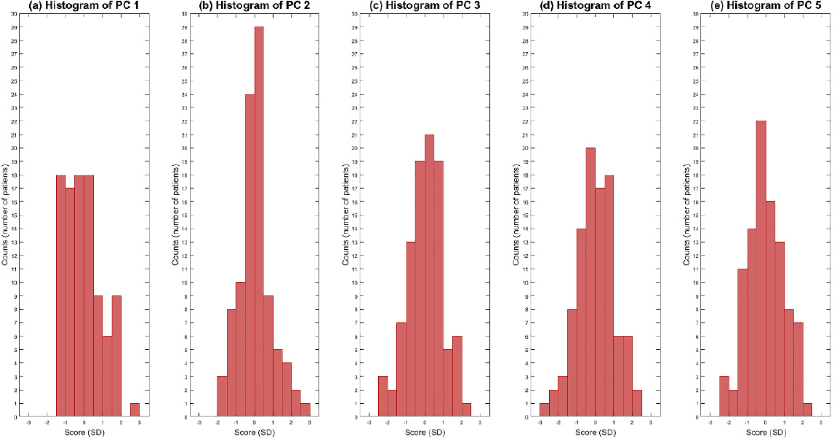
Figure A3. Histograms of the first five principal components (PCs). ( a ) The first principal component (PC) is not normally distributed; values < − 1.5 standard deviation (SD) are not present in the given dataset. Values < − 1.5 SD represent a negative neck length, which is anatomically not feasible. Therefore, only − 1 SD to +3 SD deviations are shown for PC 1. ( b – e ) The distributions of PCs 2–5.